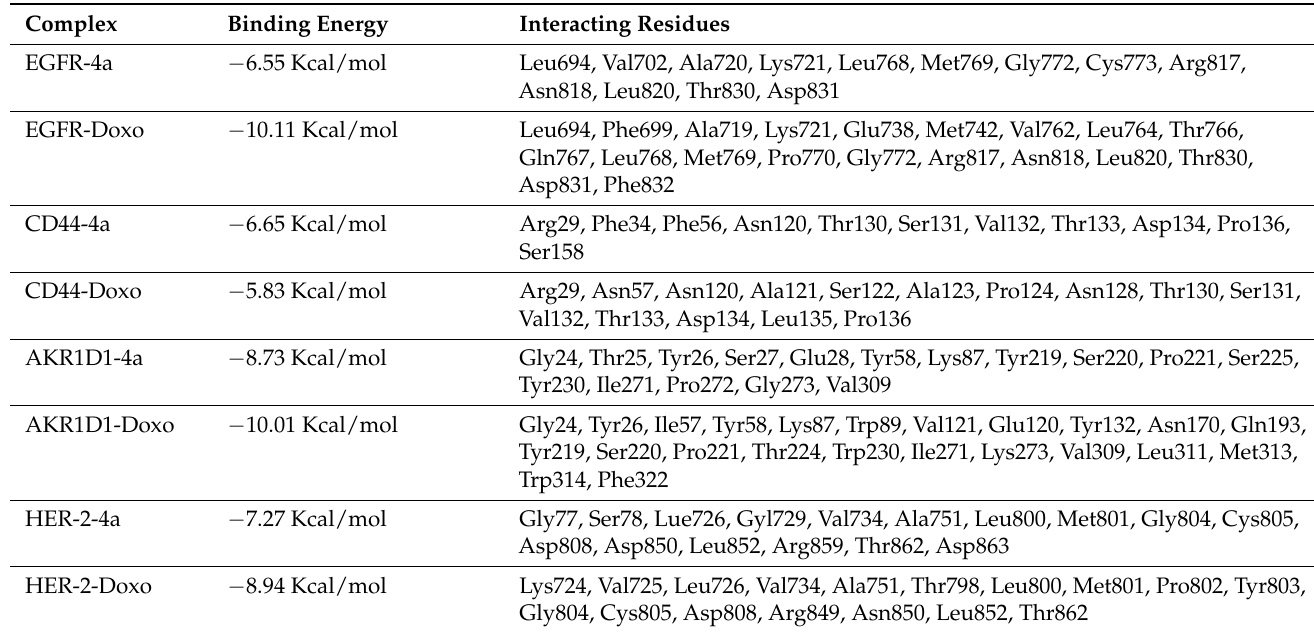
Table 4. Deep analysis of the 4a binding affinities and interacting residues of human CD44, EGFR- Tyrosine kinase domain, 5- β -reductase (AKR1D1), and